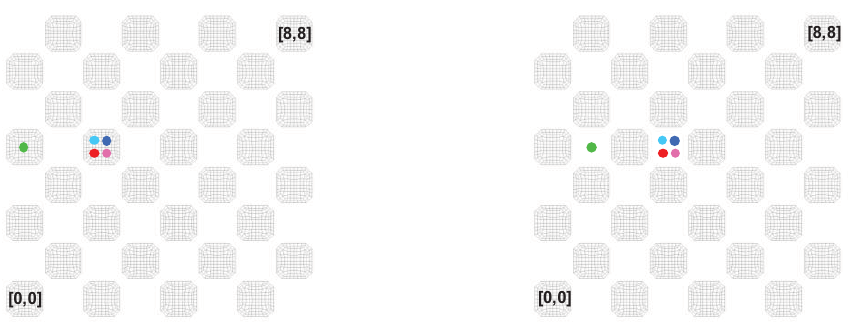
Figure 5: List of evaluated channels for each variant